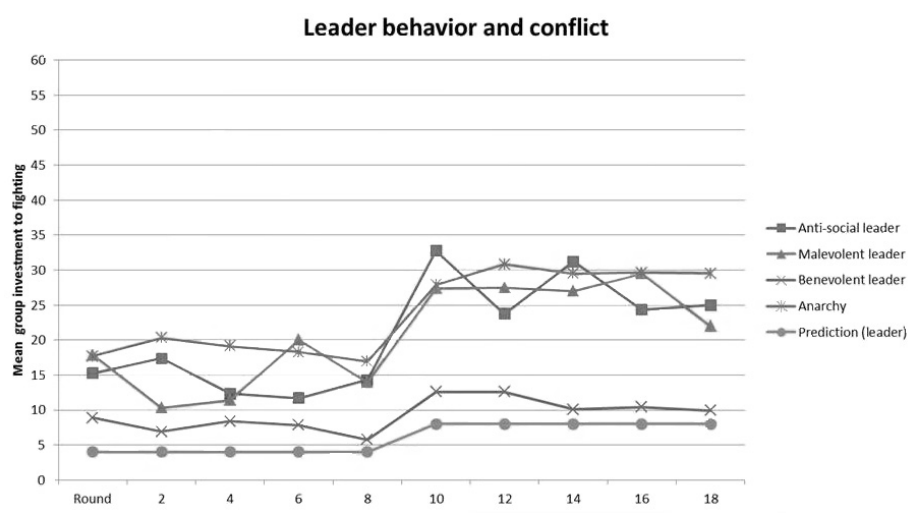
Figure 1. Quality of leadership and group